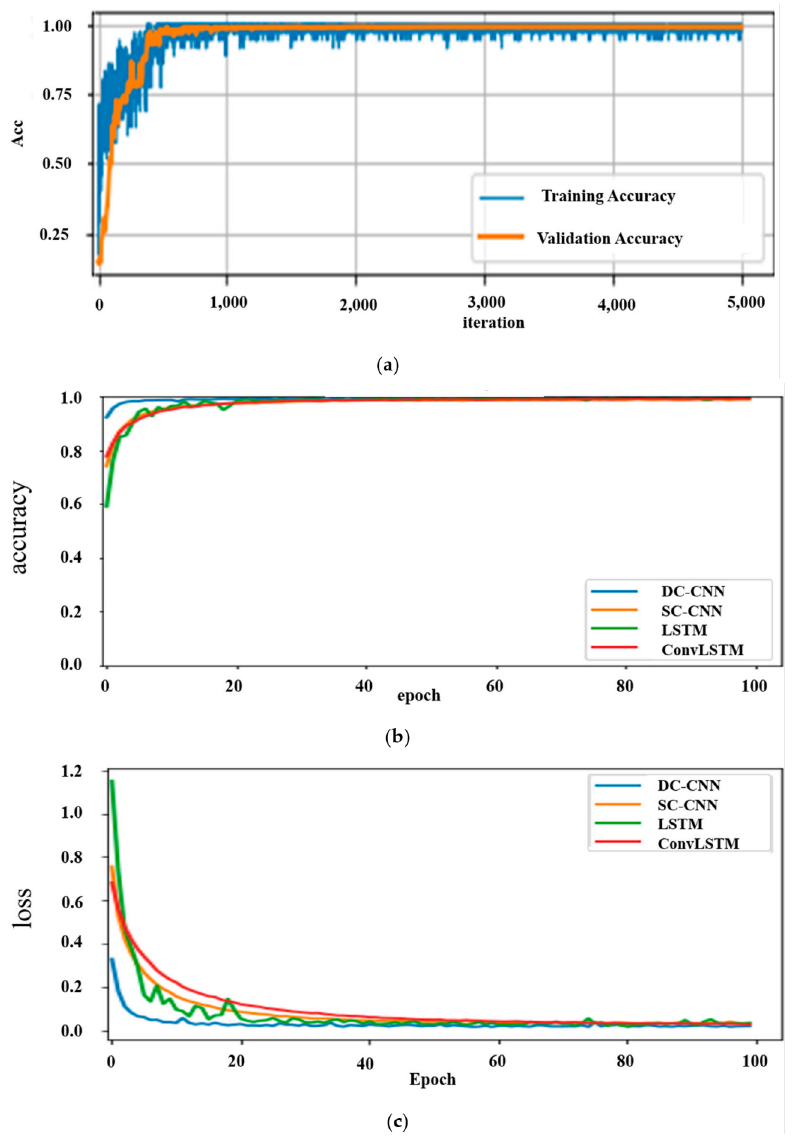
Figure 12. ( a ) DC-CNN accuracies over TD-DC; ( b ) validation accuracies; and ( c ) loss graphs of different models for validation TD dataset. Table 3. DC-CNN confusion matrix for the development